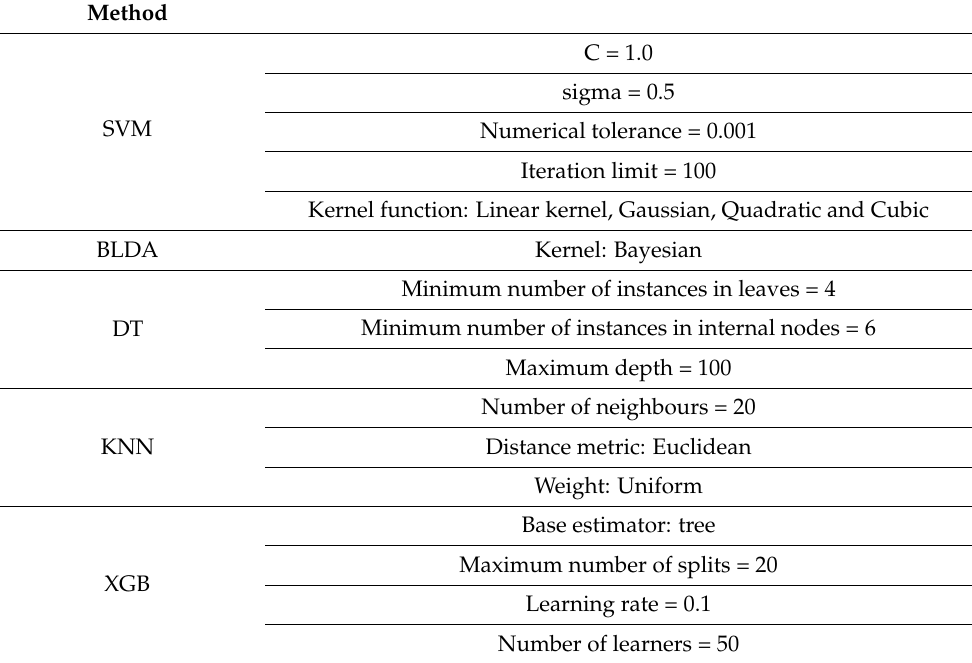
Table 2. Parameters used for the implementation of different machine learning